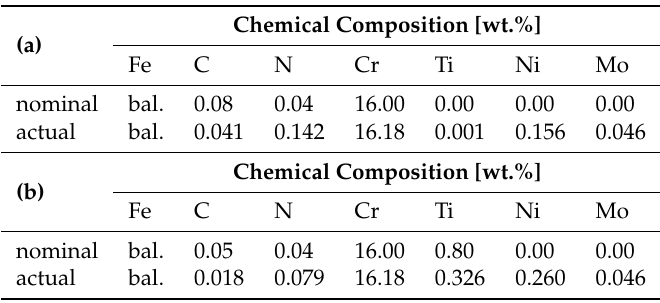
Table 1. Nominal and actual chemical compositions of the (a) AISI430 and (b) AISI430Ti sheet materials used in the investigation. Nominal chemical composition derived from [18].